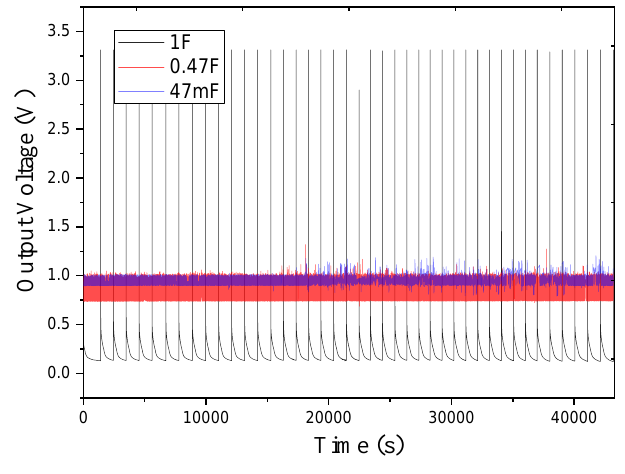
Figure 22. Voltage of test point A.